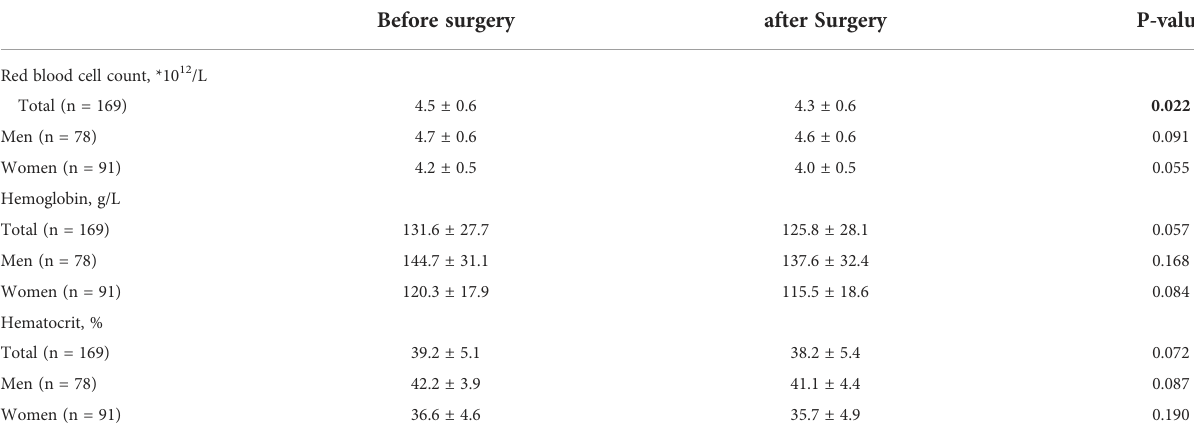
TABLE 3 Red blood cell count, hemoglobin, and hematocrit before and after surgery in patients with carotid body tumors. Before surgery after Surgery P-value